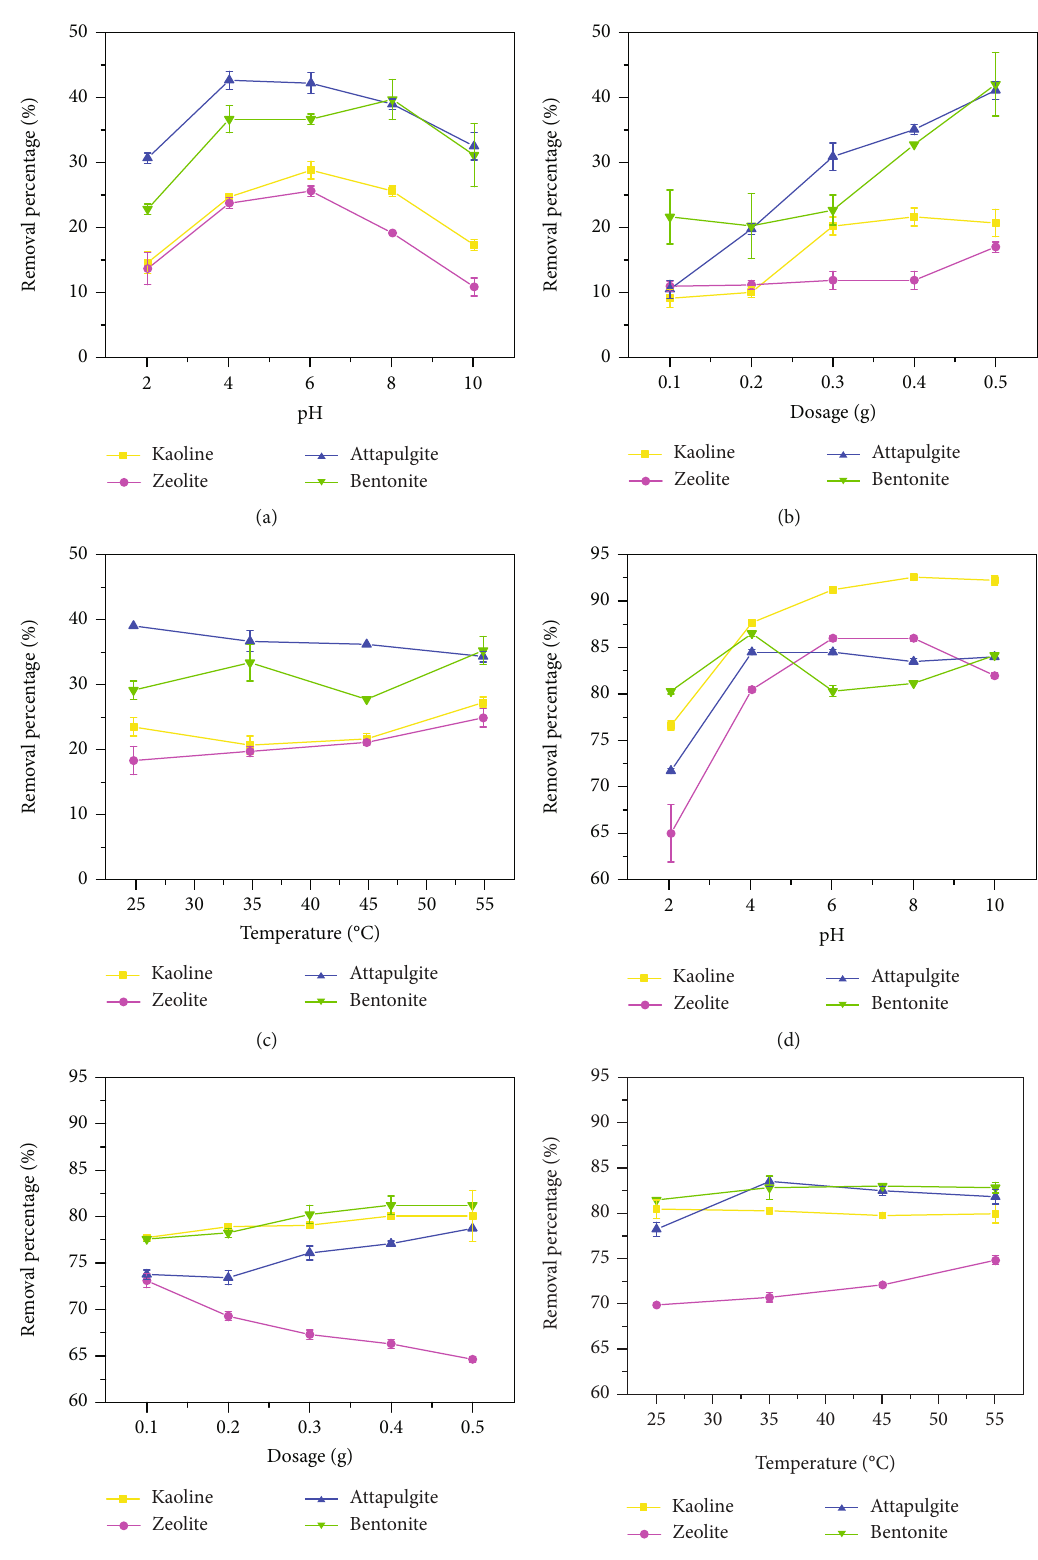
Figure 5: The removal rate of ammonia nitrogen (a – c) and phosphate (d – f) under di ff erent pH values, dosages, and